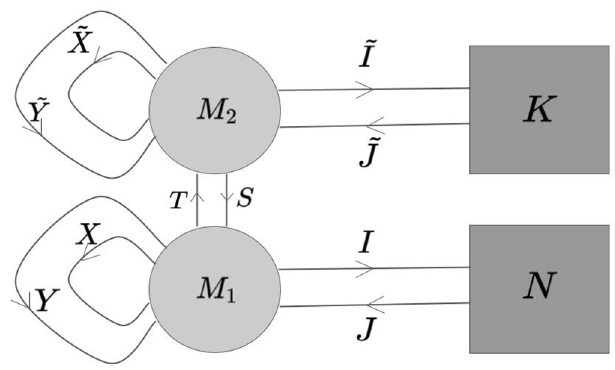
Figure 4 . Double Nakajima